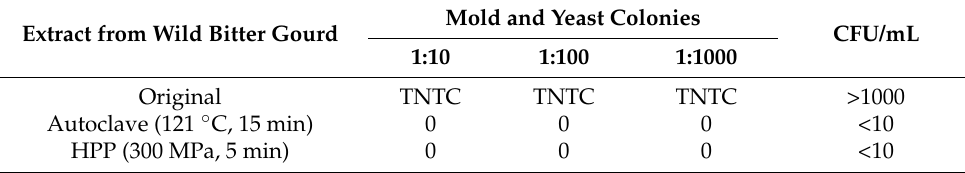
Table 4. Mold and yeast count of wild bitter gourd extract treated by different methods. Mold and Yeast Extract from Wild Bitter Gourd